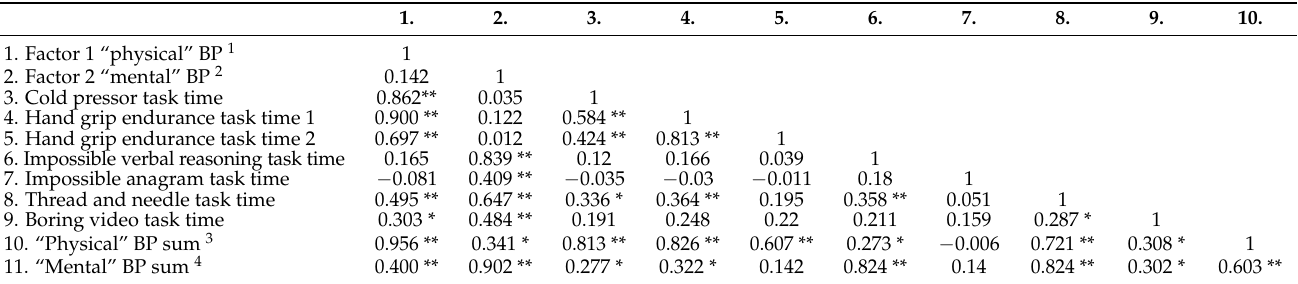
Table 4. Correlations between factor variables and tasks